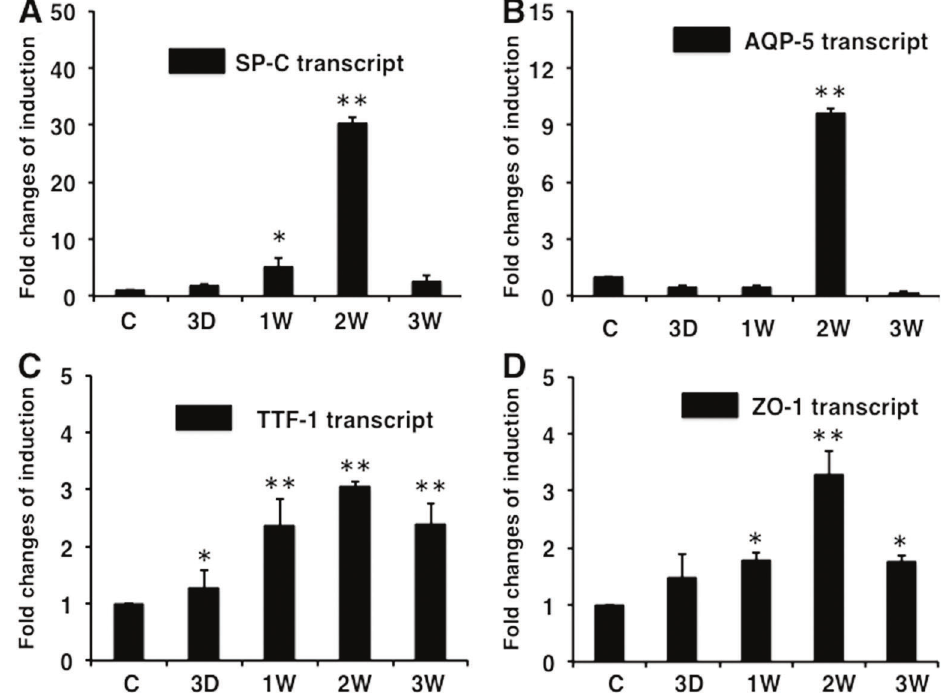
Figure 5. Transcripts of several key genes of interest in A549 cell air-liquid interface (ALI) cultures at 3 days, 1 week, 2 weeks, and 3 weeks were examined by a qRT-PCR assay. A signi fi cantly induced expression of SP-C ( A ), AQP-5 ( B ), TTF-1 ( C ), and ZO-1 ( D ) mRNAs were observed in ALI cultures compared to submerged cultures of A549 cells (control, C), particularly in the 2-week-old cultures. Data are reported as means ± SD from 3 independent experiments (n=9)., D: days; W: week(s). *P o 0.05 and **P o 0.01 compared to the submerged culture control